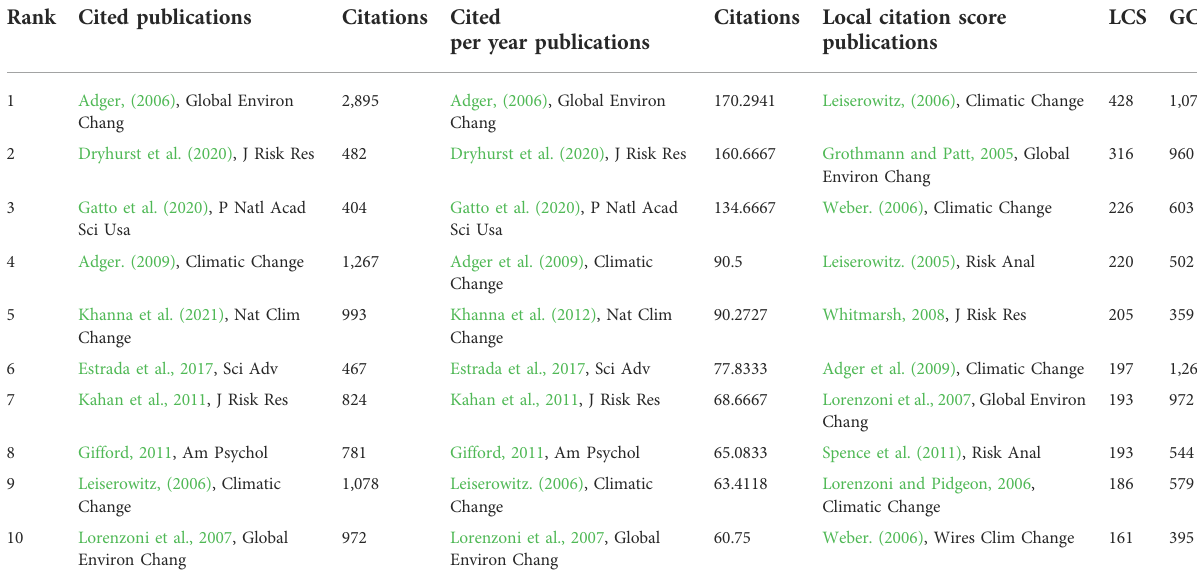
TABLE 1 The Top 10 articles according to the number of total citations and total citations per year and local citation